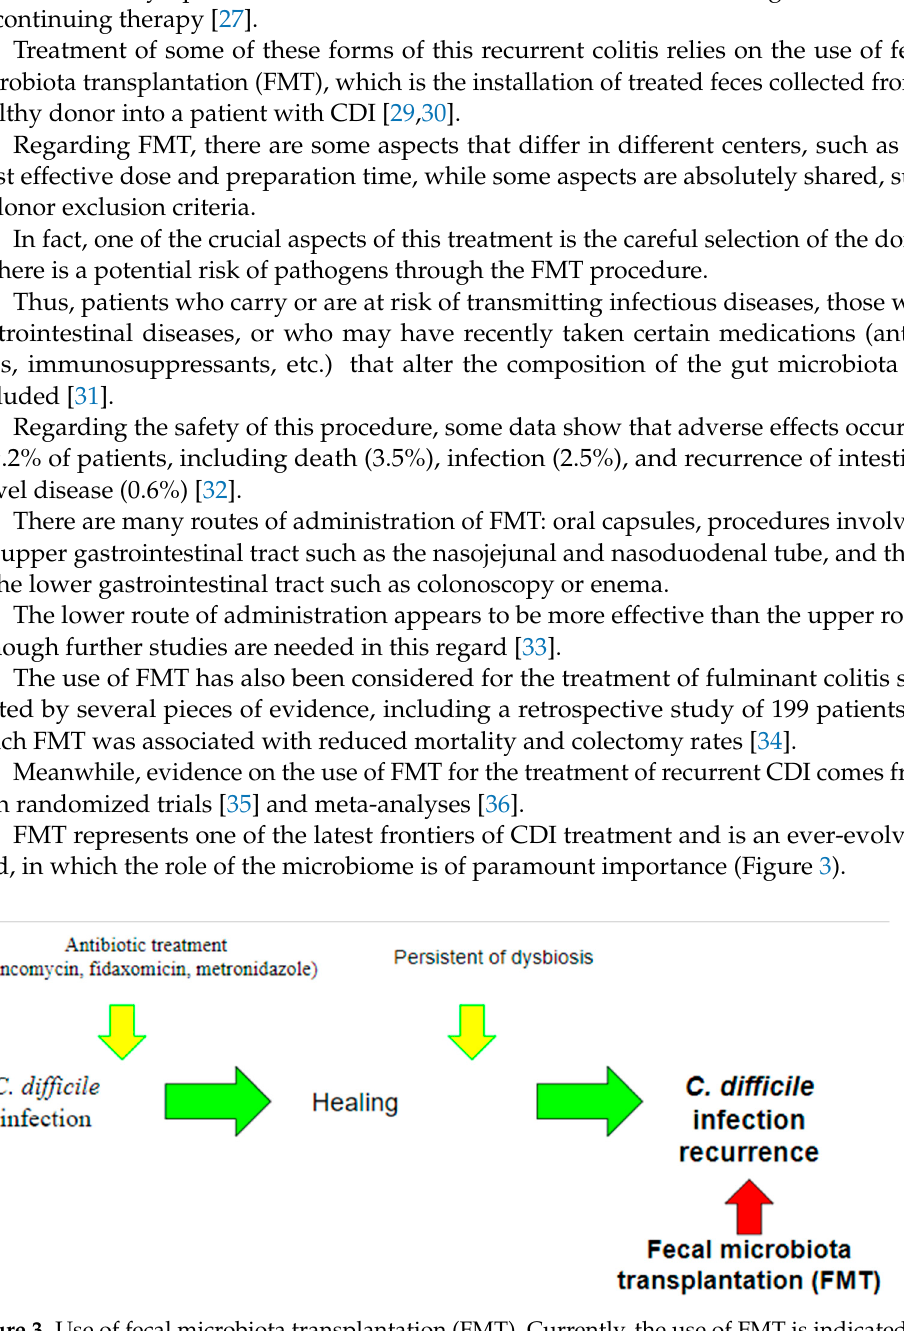
Table 3. Summary of some existing interactions between microbiome and the occurrence of Clos- tridium difficile infection.